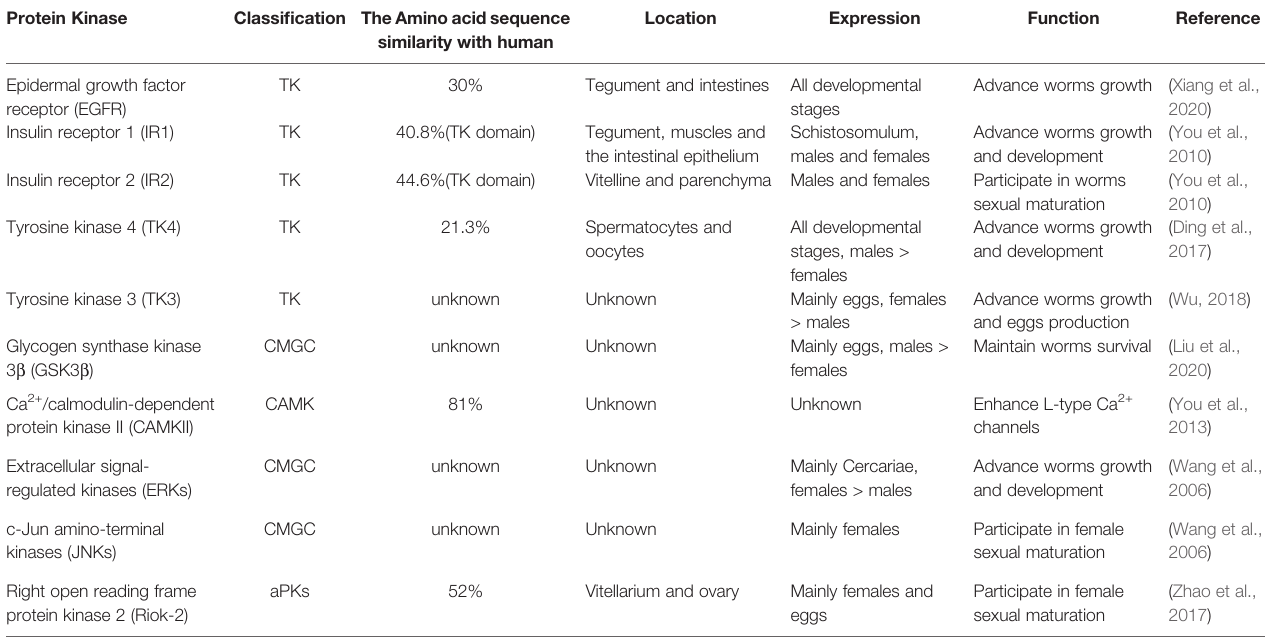
TABLE 1 | The characteristics of protein kinases in Schistosoma japonicum . Protein Kinase Classi fi cation TheAminoacidsequence similarity with human